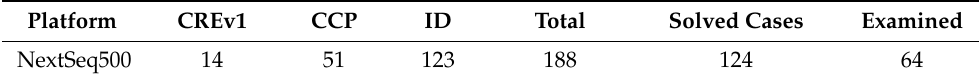
Table 5. Summary of samples used from the VRCIRD